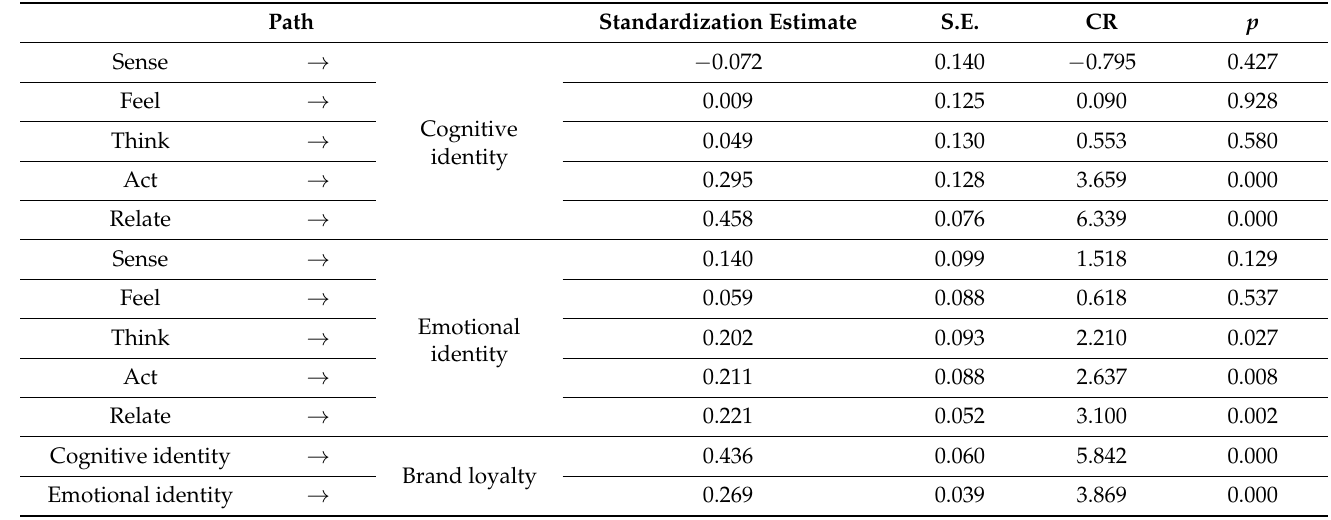
Table 4. Structural equation path results.